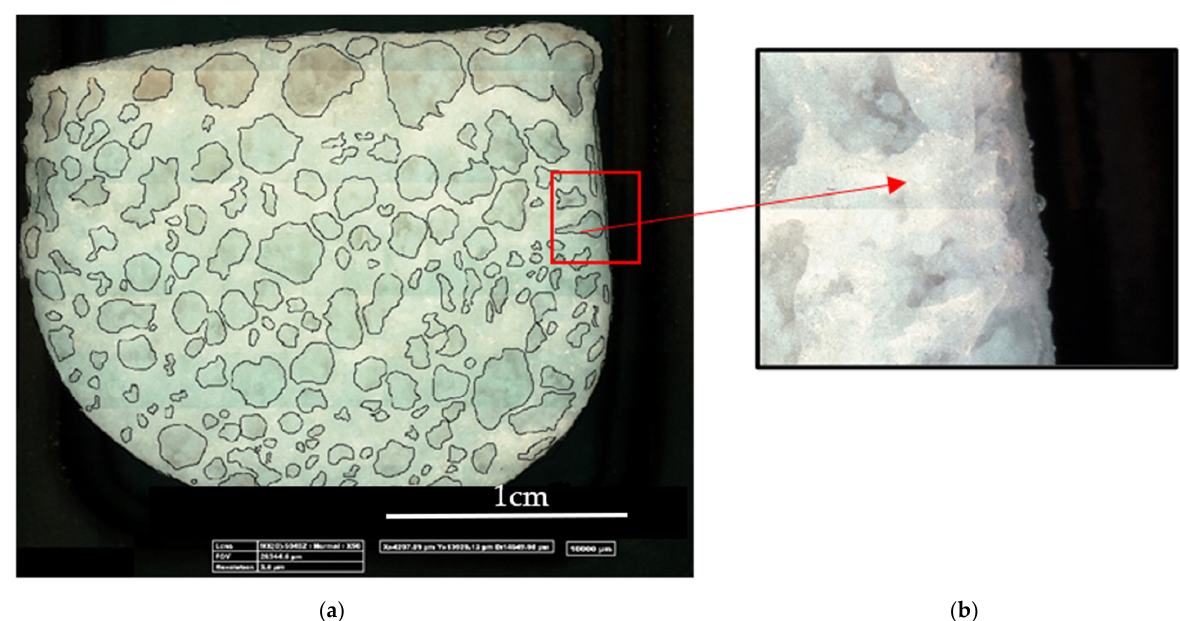
Table 1. In situ XRD pattern code, experimental conditions, refined lattice parameters, volume, and phase fraction.